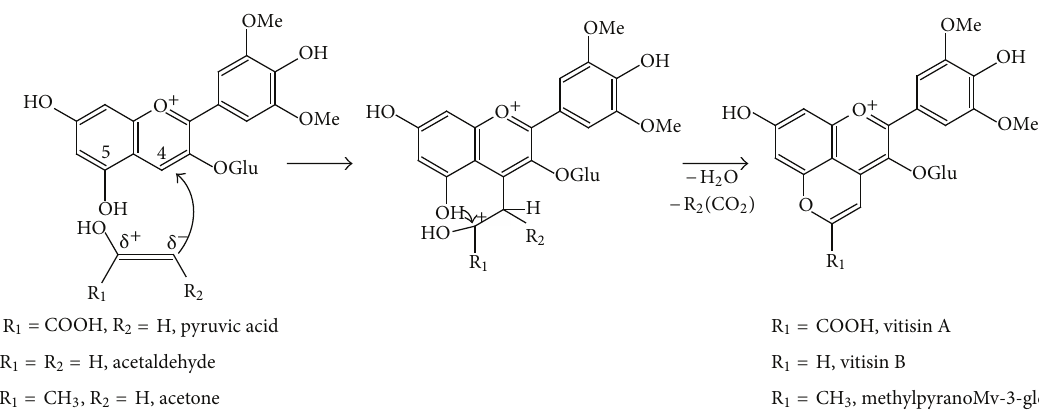
F 1: Pyranoanthocyanin formation by reaction between malvidin-3- O -glucoside and carbonyl compounds [9, 36].